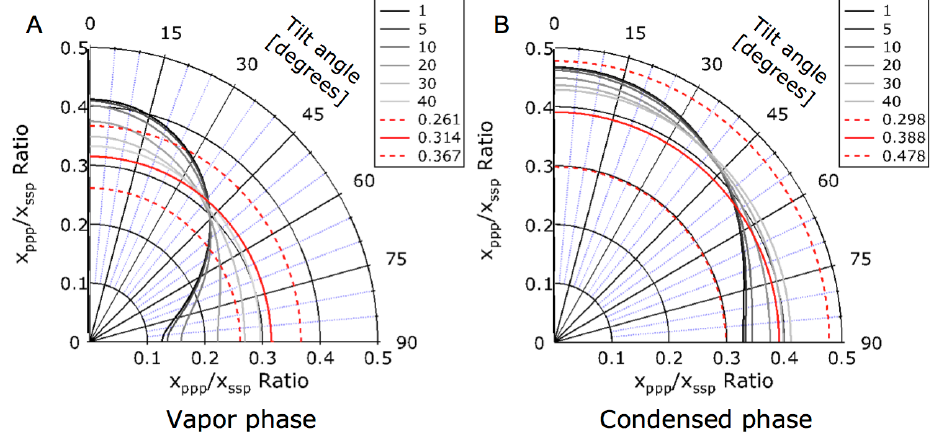
Fig. 4. Radial plots indicating methyl C 3 v tilt angle as a function of χ ppp / χ ssp amplitude ratio of the methyl symmetric stretching mode for vapor (left) and spin-coated (right) trans- β -IEPOX (1) calculated as described in the text. Solid red curves indicate the experimentally deter- mined ratio point estimates, and dashed red curves indicate the standard errors of these ratios. Gray curves indicate theoretically calculated monomodal Gaussian orientation distributions of widths ranging from 1 to 40 ◦ .